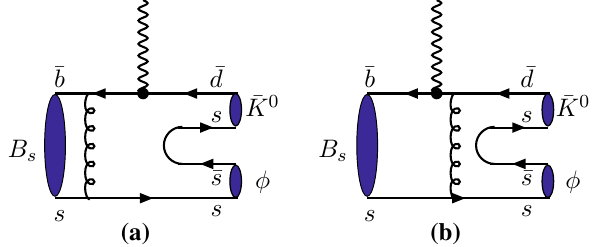
Fig. 1 Feynman diagrams of electromagnetic penguin operator O 7 γ . A photon is emitted through the O 7 γ operator, and one hard gluon is exchanged between an energy quark and the spectator quark (cid:20) (cid:19) √ × η( 2 z − 1 )(φ + φ v ) − ( z + 1 )φ h e ( x 1 z , z , b 1 , b 2 a t